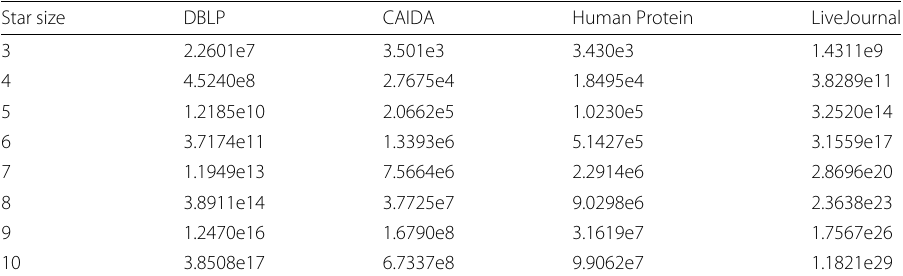
Table 5 Expected number of occurrences with RaME for induced counts of star topologies with 3-10 nodes Star size DBLP CAIDA Human Protein LiveJournal 2.2601e7